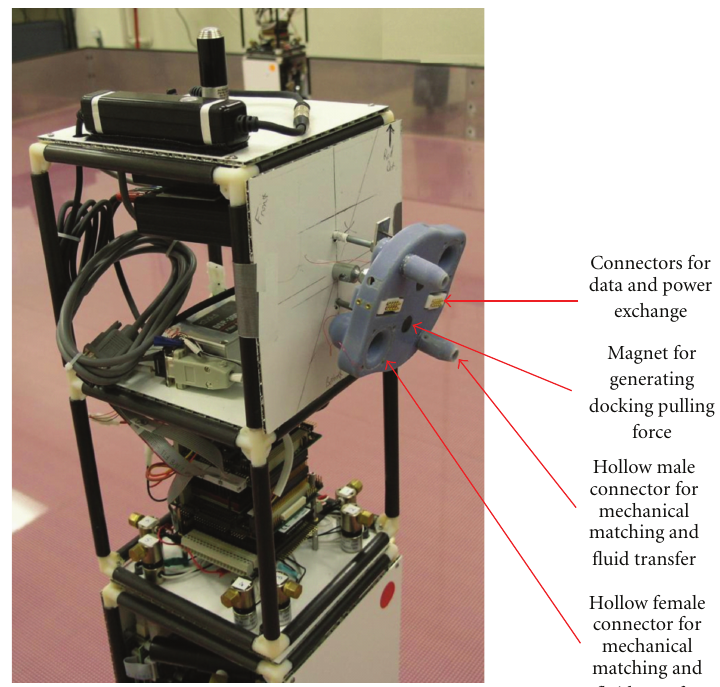
Figure 3: Main components of the patent pending docking interface.